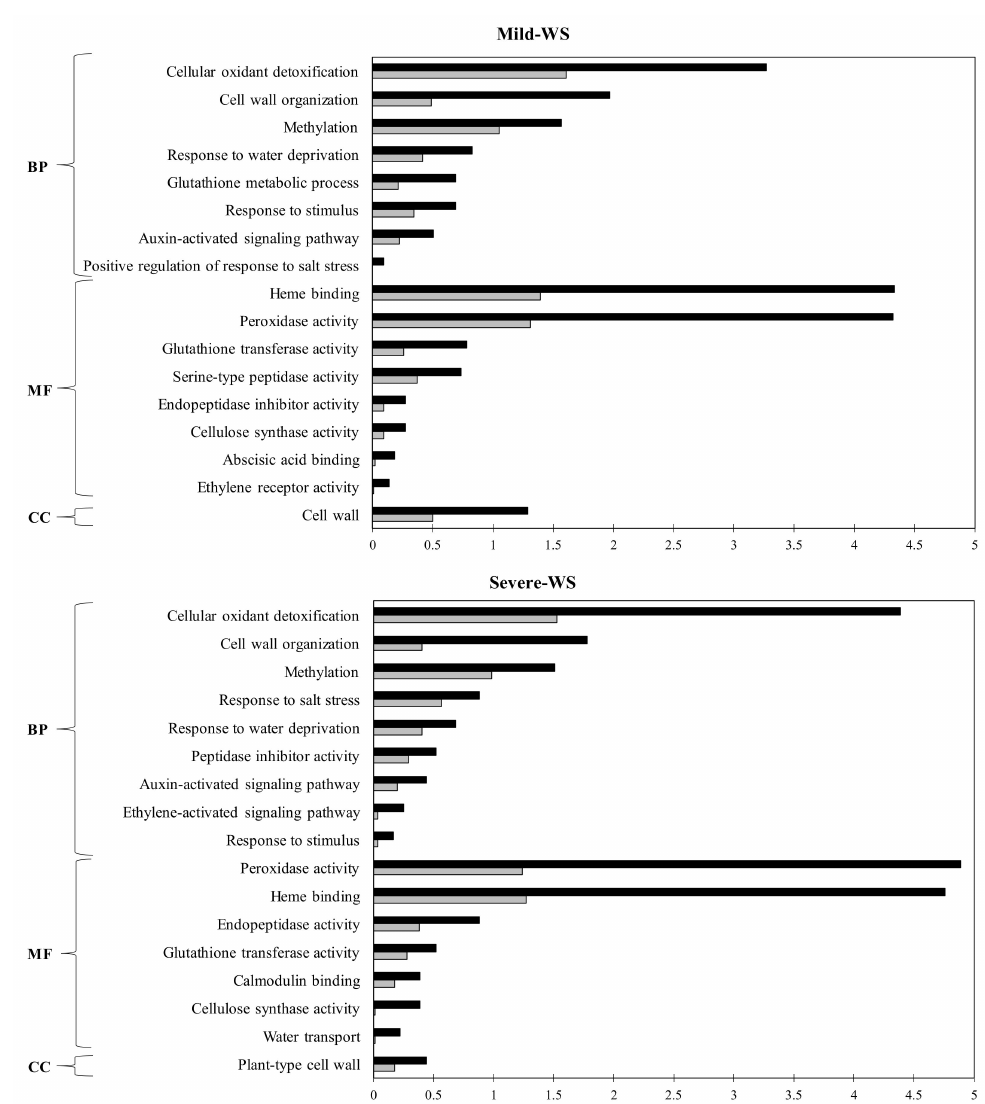
Figure 5. Gene Ontology (GO) enrichment analysis of differentially expressed genes (DEGs) in the microarray analysis of ‘Dusa’ avocado rootstocks subjected to two different levels of water stress: mild-WS (50% of Fc) and severe-WS (25% of Fc). Enrichment GO terms were obtained by Blast2GO ( p < 0.05). BP, biological process; MF, molecular function; CC, cellular component. Black bars represent test set (mild and severe-WS) while gray bars represent the reference